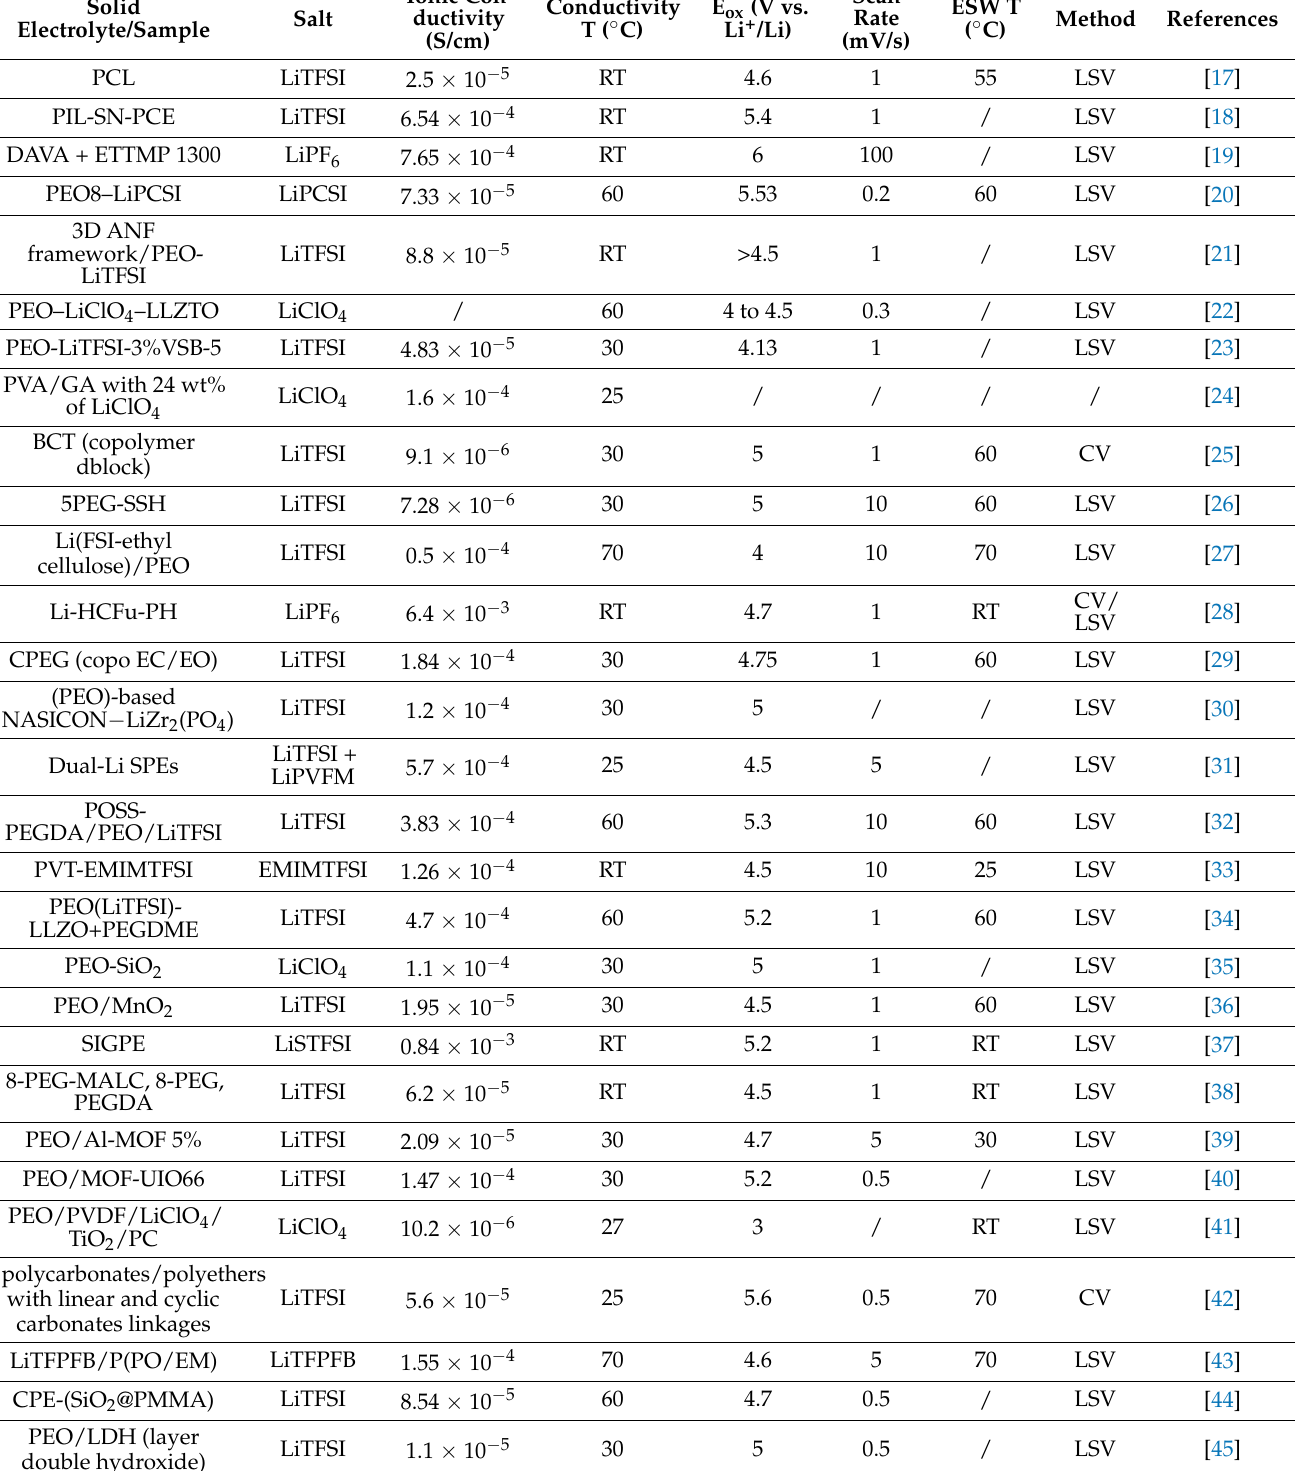
Table 1. Properties of various Solid Polymer-based electrolytes (PEO, other polymers and composites) from recent publi- cations (2019–2020). The several reported properties are the ionic conductivity, the conductivity temperature evaluation, E ox (oxidative stability of studied materials), the scanning rate for the E ox evaluation, the temperature for ESW evaluation (RT = Room temperature) and the method used for the evaluation (cyclic voltammetry, CV; Linear sweep voltammetry,